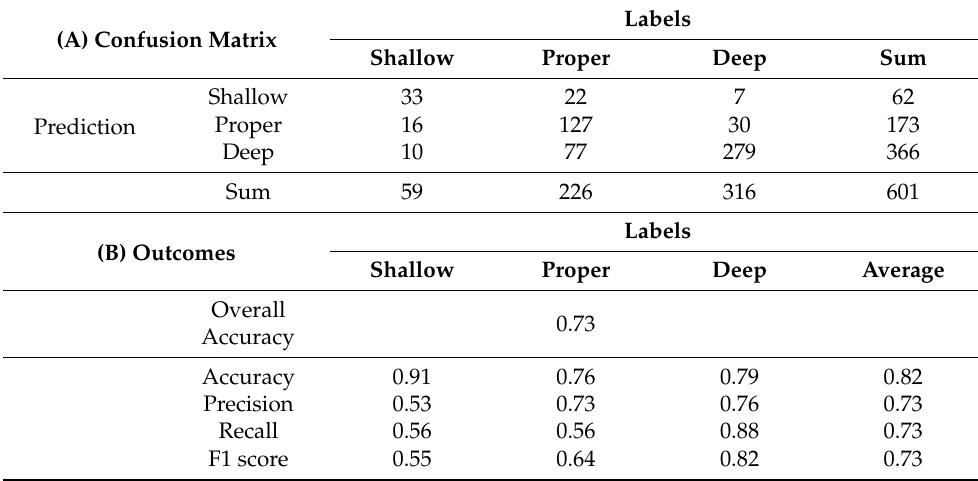
Table 3. Confusion matrix ( A ) and outcomes ( B ) of performance test for classification of three labels of segmentation-free images after training with all segmented